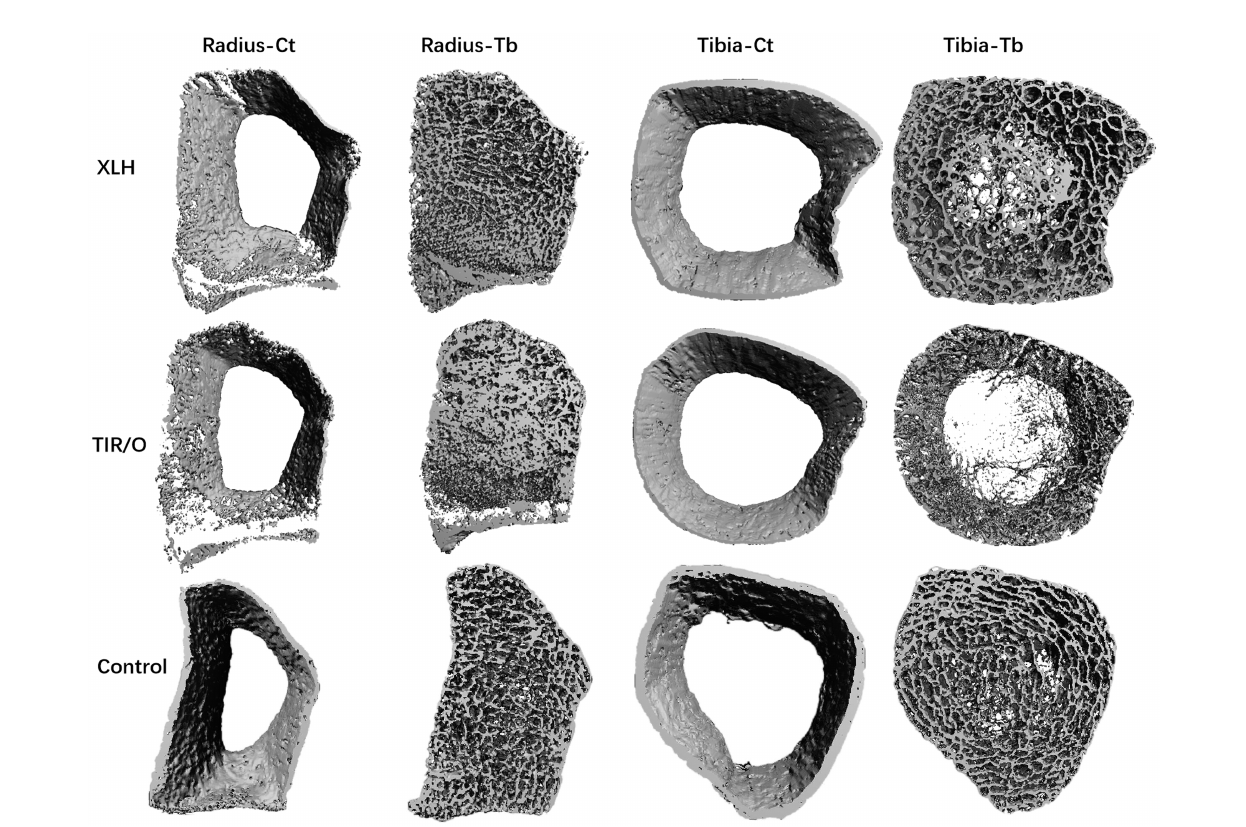
FIGURE 1 | Representative bone images constructed by high-resolution peripheral quantitative computed tomography. The patient with TIR/O is an 18-year-old female subject with a height of 153 cm, the patient with XLH is an 18-year-old female subject with a height of 155 cm, and the healthy control is an 18-year-old female subject with a height of 160 cm. Note the clear differences in the trabecular network. Compared with the XLH patient and the healthy control, the trabecular bone microarchitecture is dramatically impaired in the TIR/O patient, especially at the distal tibia, with less trabecular number and larger trabecular separation. The cortical compartment is more affected at the distal radius in both the TIR/O patient and the XLH patient compared with the healthy control, with thinner cortical thickness and higher cortical porosity. TIR/O, tumor-induced rickets/osteomalacia; XLH, X-linked hypophosphatemia; Ct, cortical; Tb,